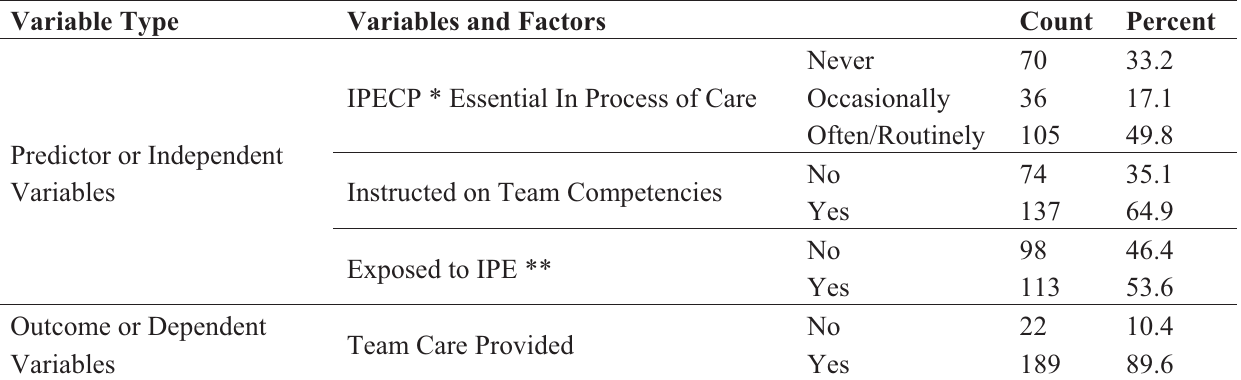
Table 5. Preliminary descriptive statistics for network user survey NCDR